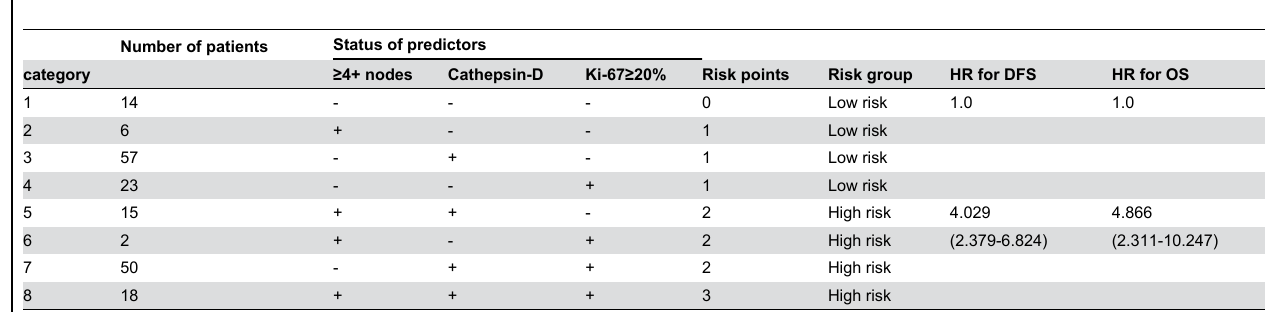
Table 3. Prognostic model comprised of risk categories based on the status of predictors.